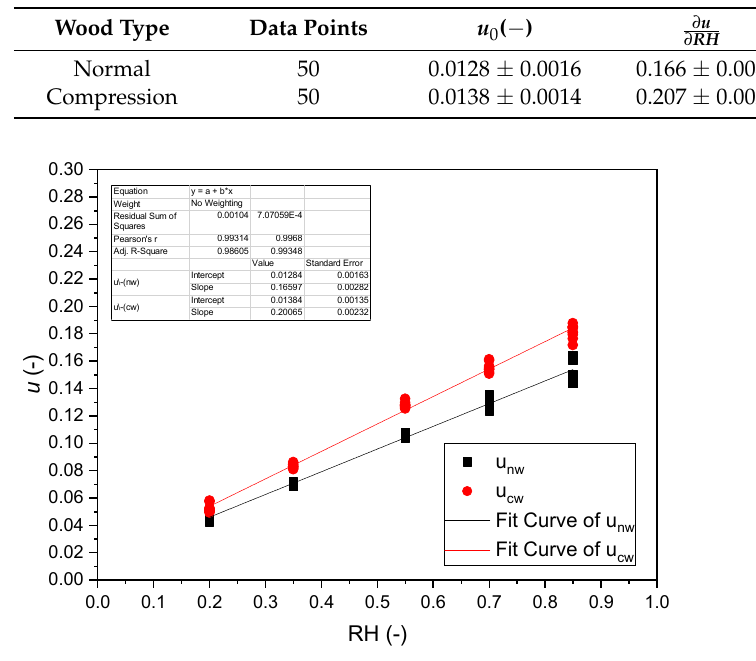
ΔRH (see Equation (5)) of nor- (cid:2986)((cid:3019)(cid:3009)) ∆ RH (see Equation (5)) of ∂ ( RH )